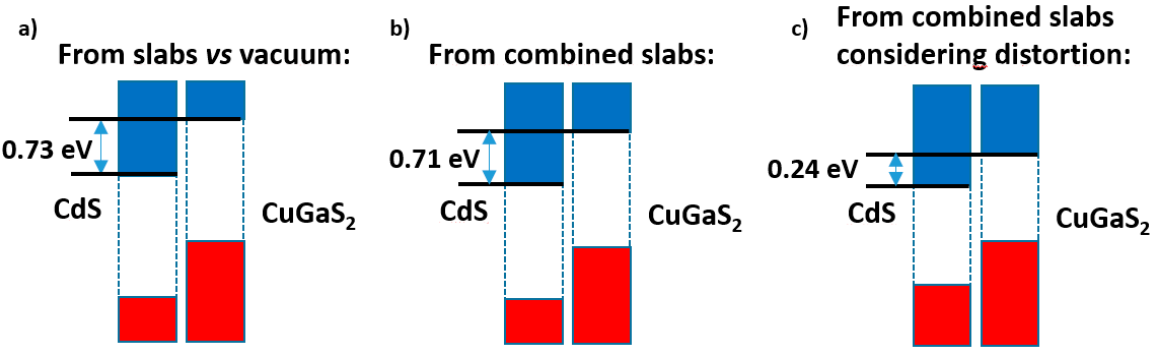
Figure 8. Band offsets found for the CdS|CuGaS 2 case: ( a ) in the slabs versus vacuum method; ( b ) in the combined slab method, if the lattice distortions are disregarded; ( c ) with these latter taken into account.